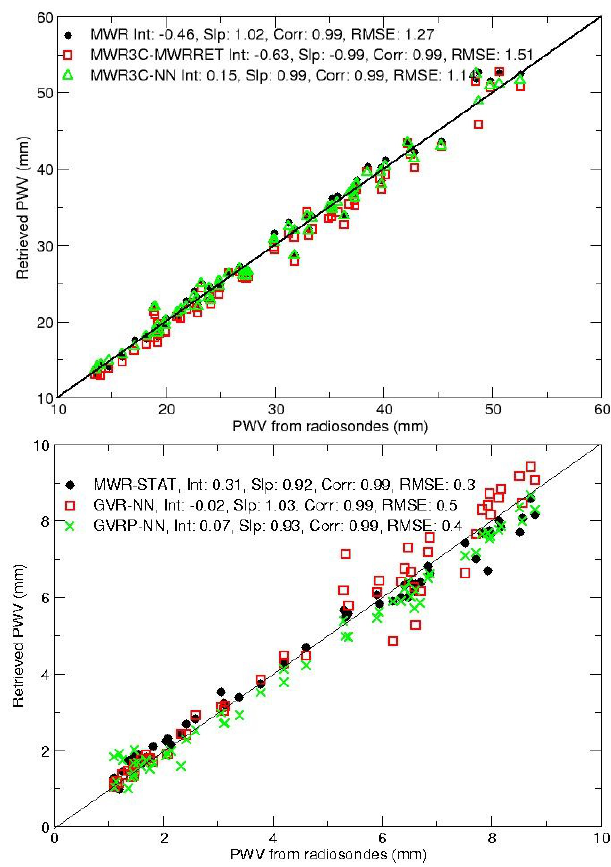
Fig. 11. Top panel: PWV retrieved from the MWR3C and MWR compared to PWV from radiosondes at the SGP site in August 2012 ( N = 67). Bottom panel: PWV retrieved from the MWR (black dots), GVR (open squares), and GVRP (crosses) compared to PWV from radiosondes at the NSA site in January 2011, ( N = 58).